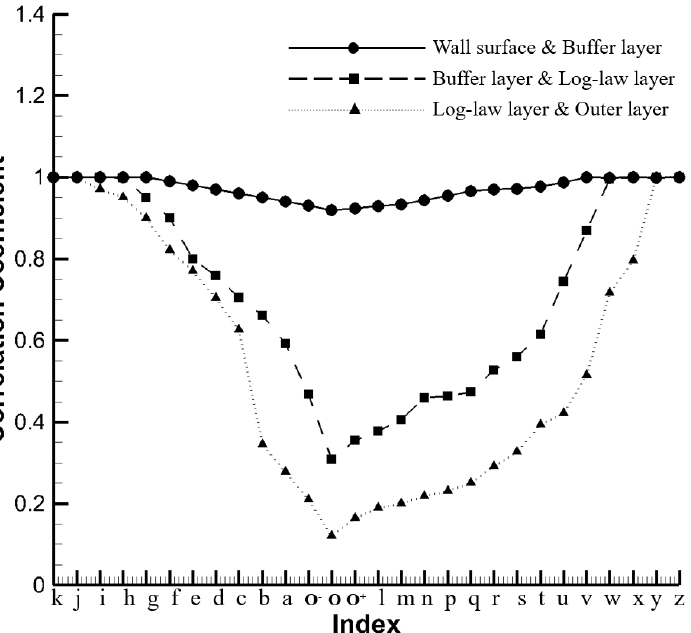
Figure 14. The distribution of the correlation coefficient between different layers near expansion